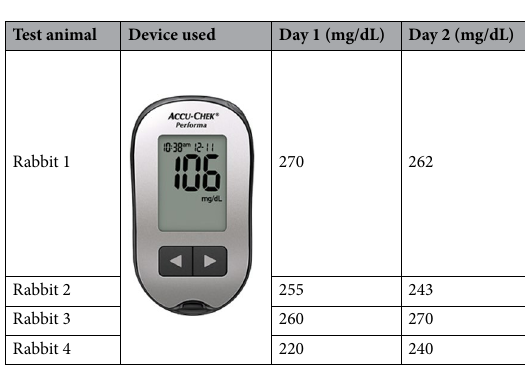
Table 7. Blood glucose results.